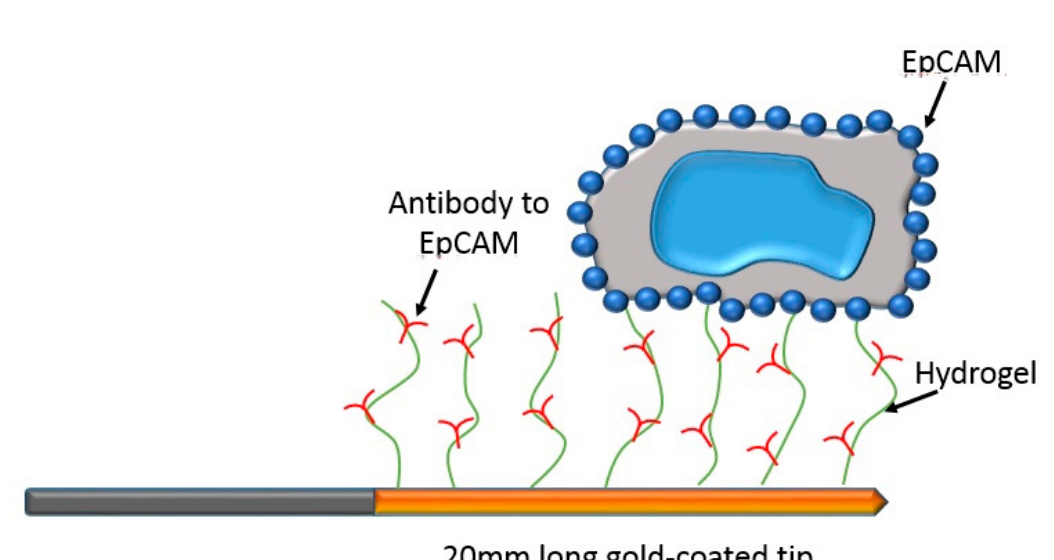
Figure 5. Illustration of the medical wire capturing circulating tumor cells in